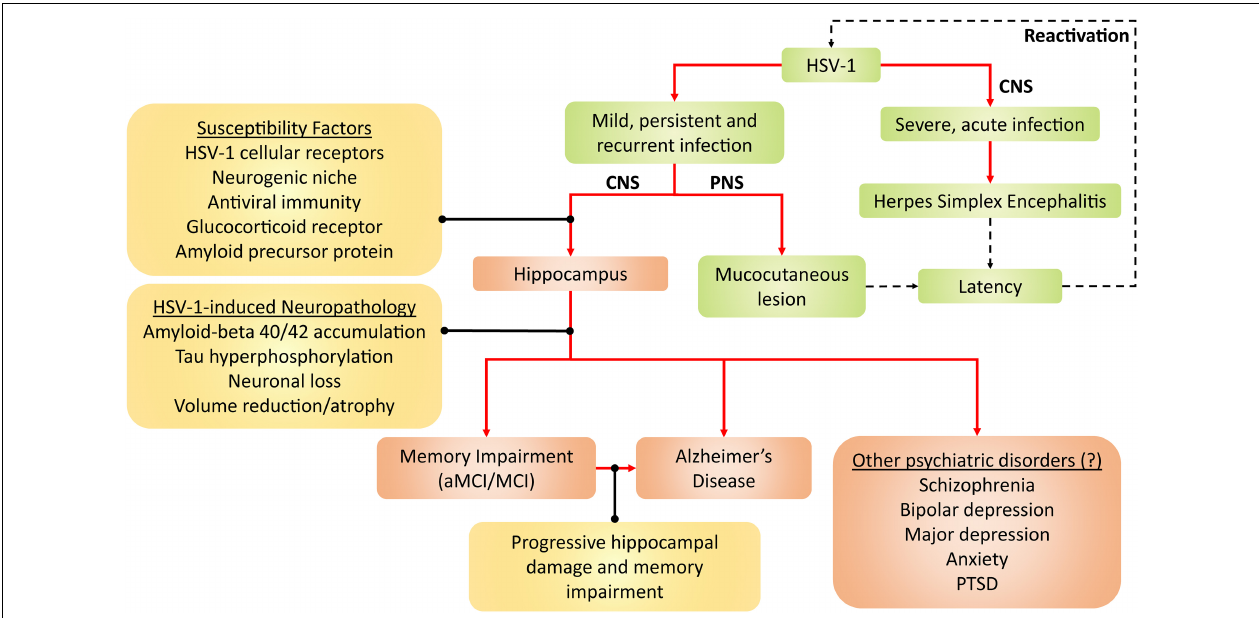
FIGURE 2 | Framework for HSV-1 pathogenicity. Green denotes established disease pathways wherein mild HSV-1 infection causes mucocutaneous lesions of the lips (cold sores), genitals (genital herpes), and cornea (keratitis). Severe HSV-1 infection causes herpes simplex encephalitis (HSE). Following productive infection (dashed arrows), HSV-1 establishes latency in the trigeminal ganglion and olfactory bulb, and periodically reactivates. Red-brown denotes current and emerging putative pathogenicity pathways, wherein HSV-1 preferentially infects the hippocampus due to several susceptibility factors. HSV-1 consequently induces neuropathological effects and, thus, compromises hippocampal functions. As a result, memory becomes impaired, which may lead to aMCI/MCI and AD. Alternatively, the progressive HSV-1-induced hippocampal damage may facilitate the progression from aMCI/MCI to AD. Given that hippocampal dysfunction may be present in other neuropsychiatric disorders such as schizophrenia, PTSD, depressive and anxiety disorders, HSV-1 may hypothetically contribute to such disorders as well. A β , amyloid-beta; AD, Alzheimer’s disease; aMCI, amnestic mild cognitive impairment; CNS, central nervous system; HSV-1, herpes simplex virus type 1; MCI, mild cognitive impairment; PNS, peripheral nervous system; PTSD, post-traumatic stress